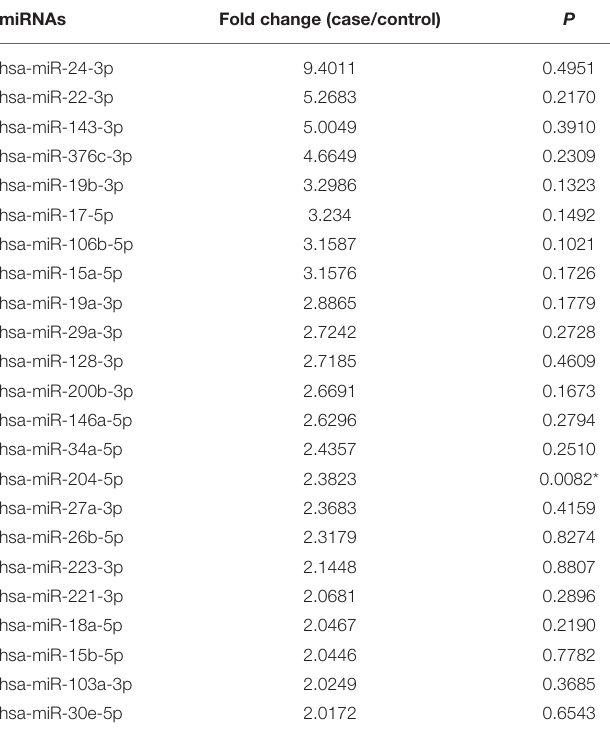
TABLE 2 | Fold-change values for the circulating miRNAs expression in plasma from pregnant who developed severe preeclampsia (case group) compared with those who remained healthy during pregnancy (control